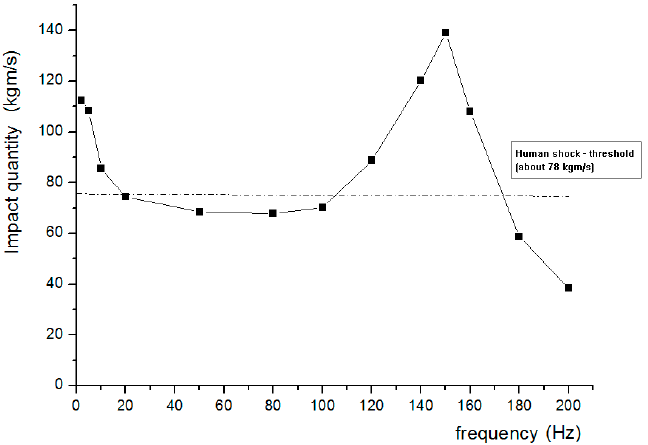
Figure 13. Impact amount of lithium battery during vibration and mechanical shock test.